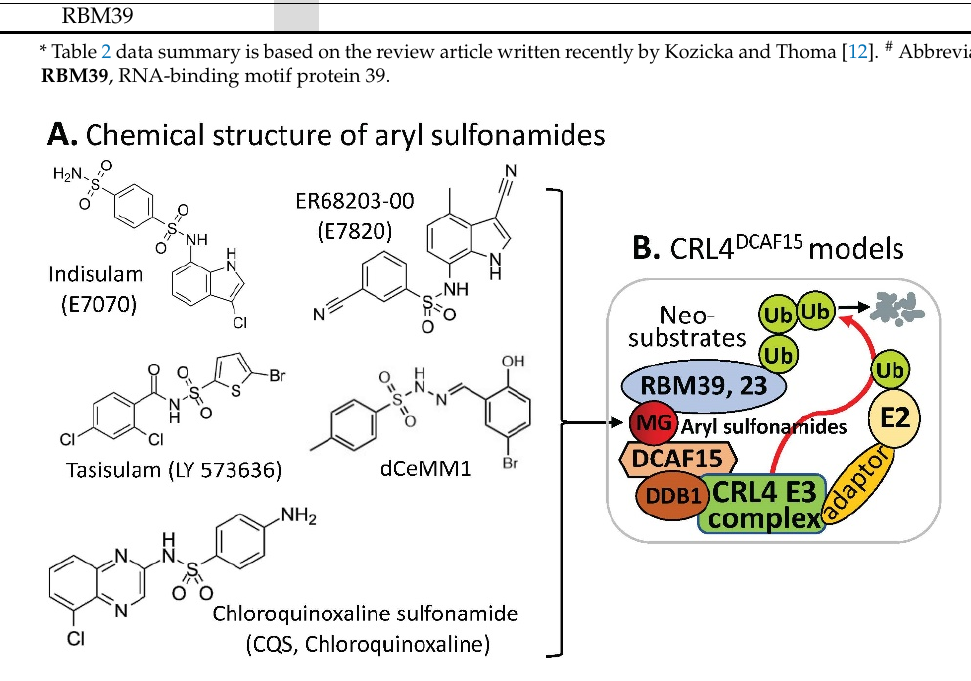
Figure 3. ( A ) The aryl sulfonamide type MG compounds’ chemical structures; ( B ) the substrate re- ceptor DCAF15-involved E3 ligase protein complex model. Each compound in ( A ) was documented